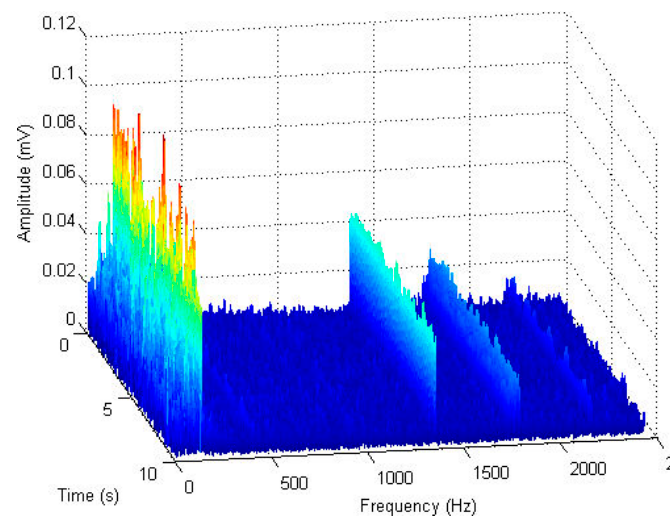
Figure 13. STFT of the vibration slew bearing signal (data on 3 May).